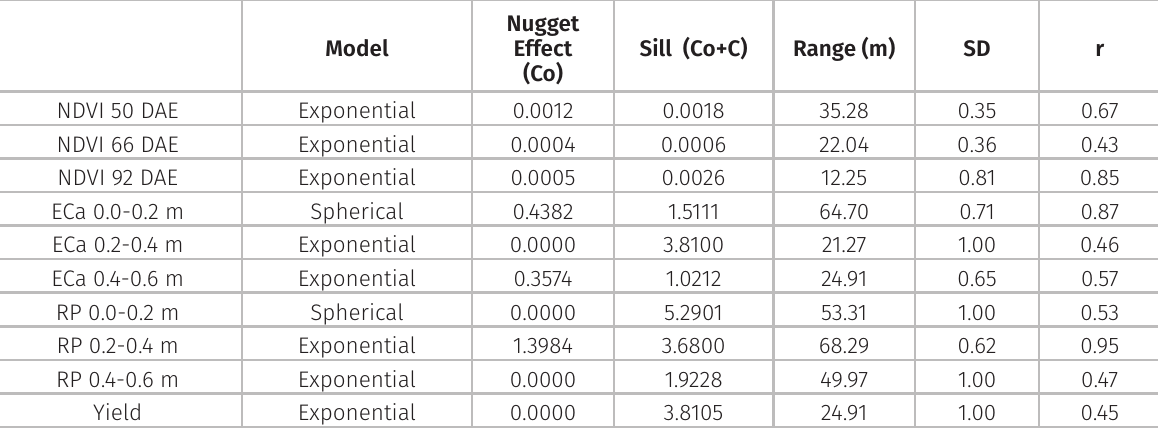
Table II. Parameters of the semivariograms adjusted for the phenological variables and the soybean vegetation